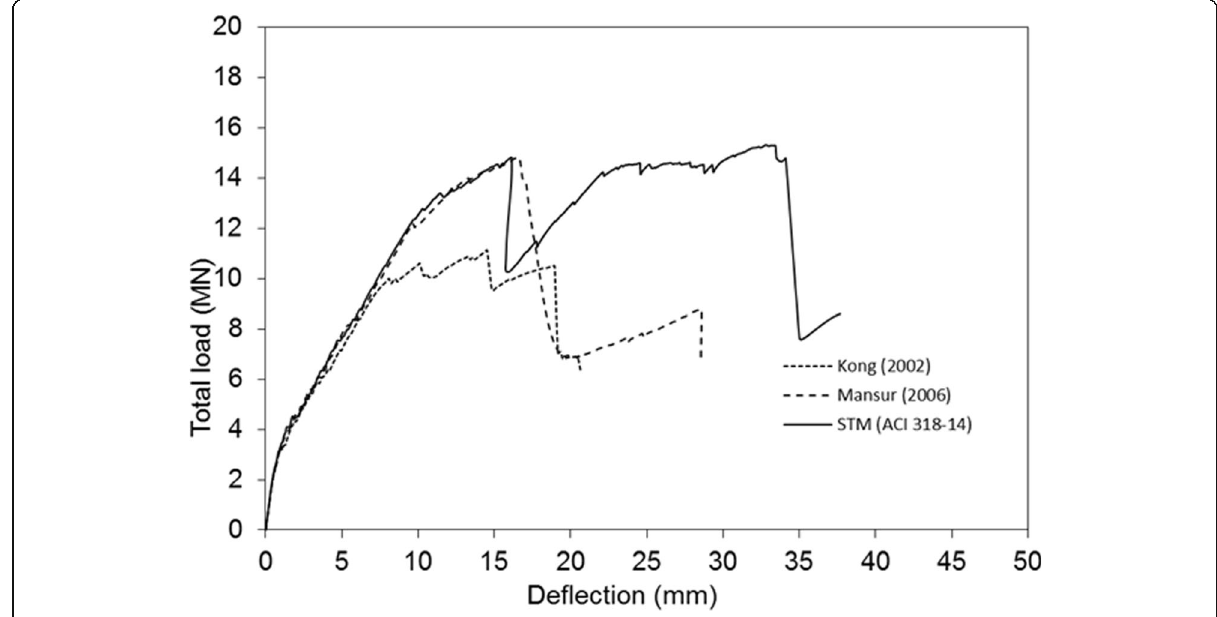
Fig. 10 Load-deflection curves of a transfer deep beam from the FE analyses for the designs of the three